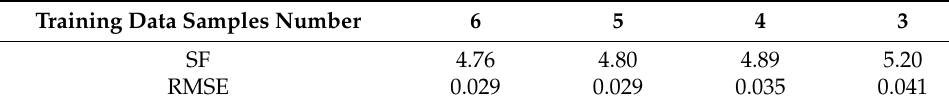
Table 4. Generalization capability analysis of the proposed